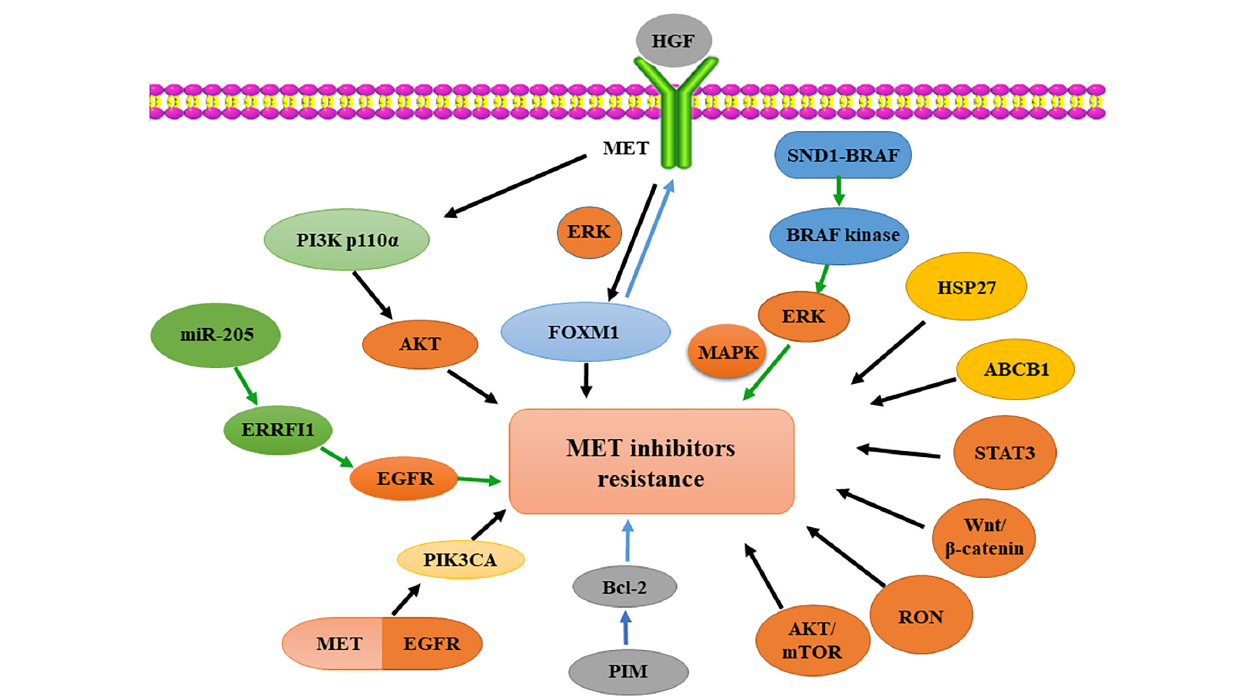
FIGURE 2 | Oncogenic activation involved in resistance to MET-targeted therapy. Activated MET regulates FOXM1 expression in therapeutic resistance via ERK signaling. SND1-BRAF activates BRAF kinase, subsequently phosphorylating ERK and activating MAPK. Overexpression of HSP27 or ABCB1 and activation of STAT3, Wnt/ β -catenin, RON or AKT/mTOR signaling pathways induce resistance to MET inhibition. PIM kinase regulates Bcl-2 translation in resistance to MET inhibition. MET-EGFR heterodimerization activates PIK3CA; PI3K p110 α overexpression induces resistance to MET inhibition by activated AKT. MiR-205 upregulation reduces the expression of ERRFI1 and increases EGFR activity, causing MET-targeted resistance. HGF, hepatocyte growth factor; FOXM1, forkhead box M1; ERK, extracellular signal-regulated kinase; MAPK, mitogen-activated protein kinase; HSP27, heat-shock protein 27; ABCB1, ATP-binding cassette subfamily B member 1; STAT3, signal transducers and activators of transcription 3; RON, receptor originated from Nantes; mTOR, mammalian target of rapamycin; AKT, protein kinase B; EGFR, epidermal growth factor receptor; PI3K, phosphatidylinositide 3-kinase; ERRFI1, ERBB receptor feedback inhibitor-1; PIK3CA, phosphatidylinositol-4,5-bisphosphate 3-kinase, catalytic subunit alpha; PIM, proviral integration site for Moloney murine leukemia virus; miR,